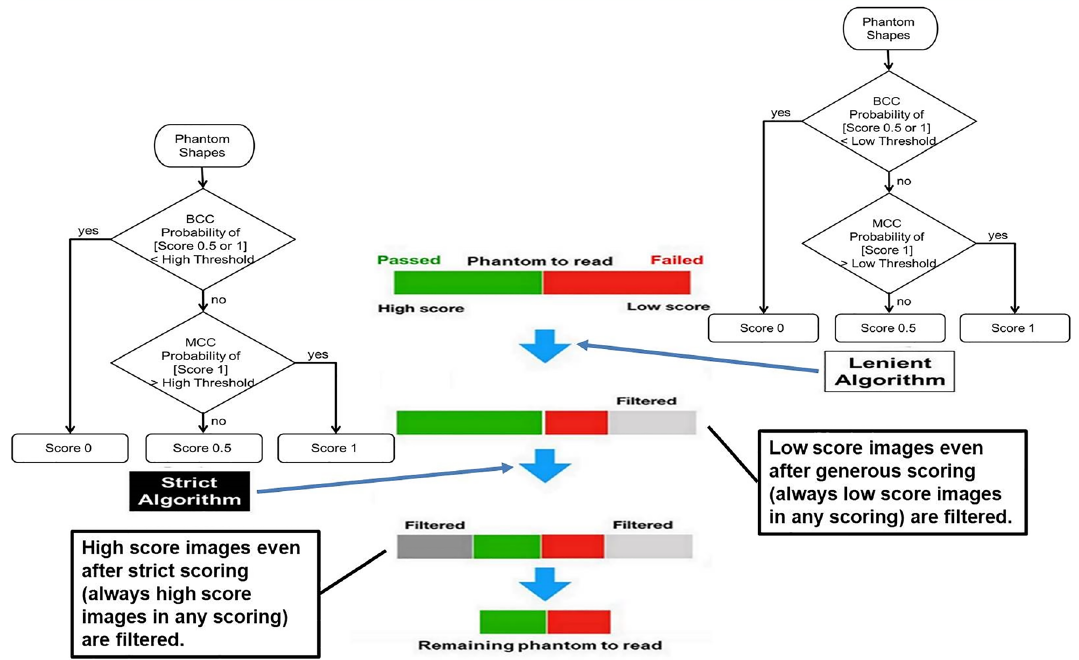
Figure 5. The phantom image filtering using the deep neural network based phantom shape scoring (DPS) models. The phantom images are filtered using two types of algorithms based on DPS models. The lenient algorithm filters phantoms that are to be determined as failed. The strict algorithm filters phantoms that are to be determined as